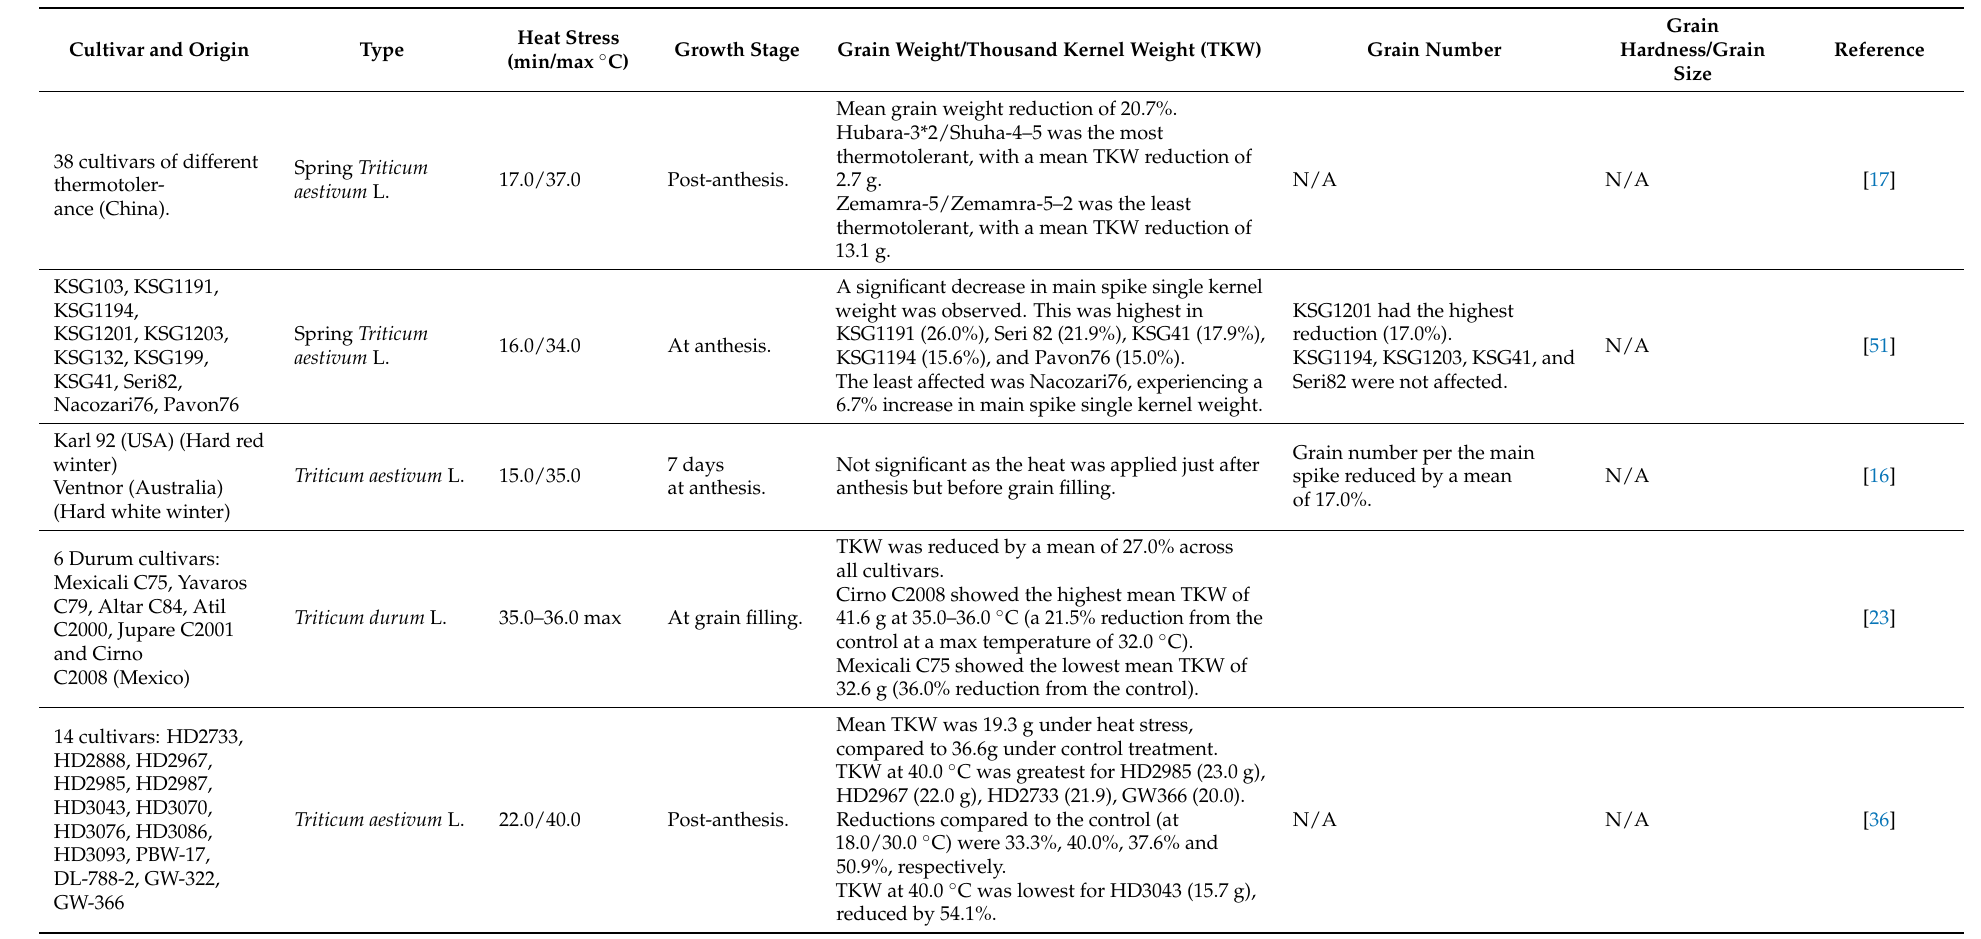
Table 2. The effect of post-anthesis heat stress on the physical quality of wheat